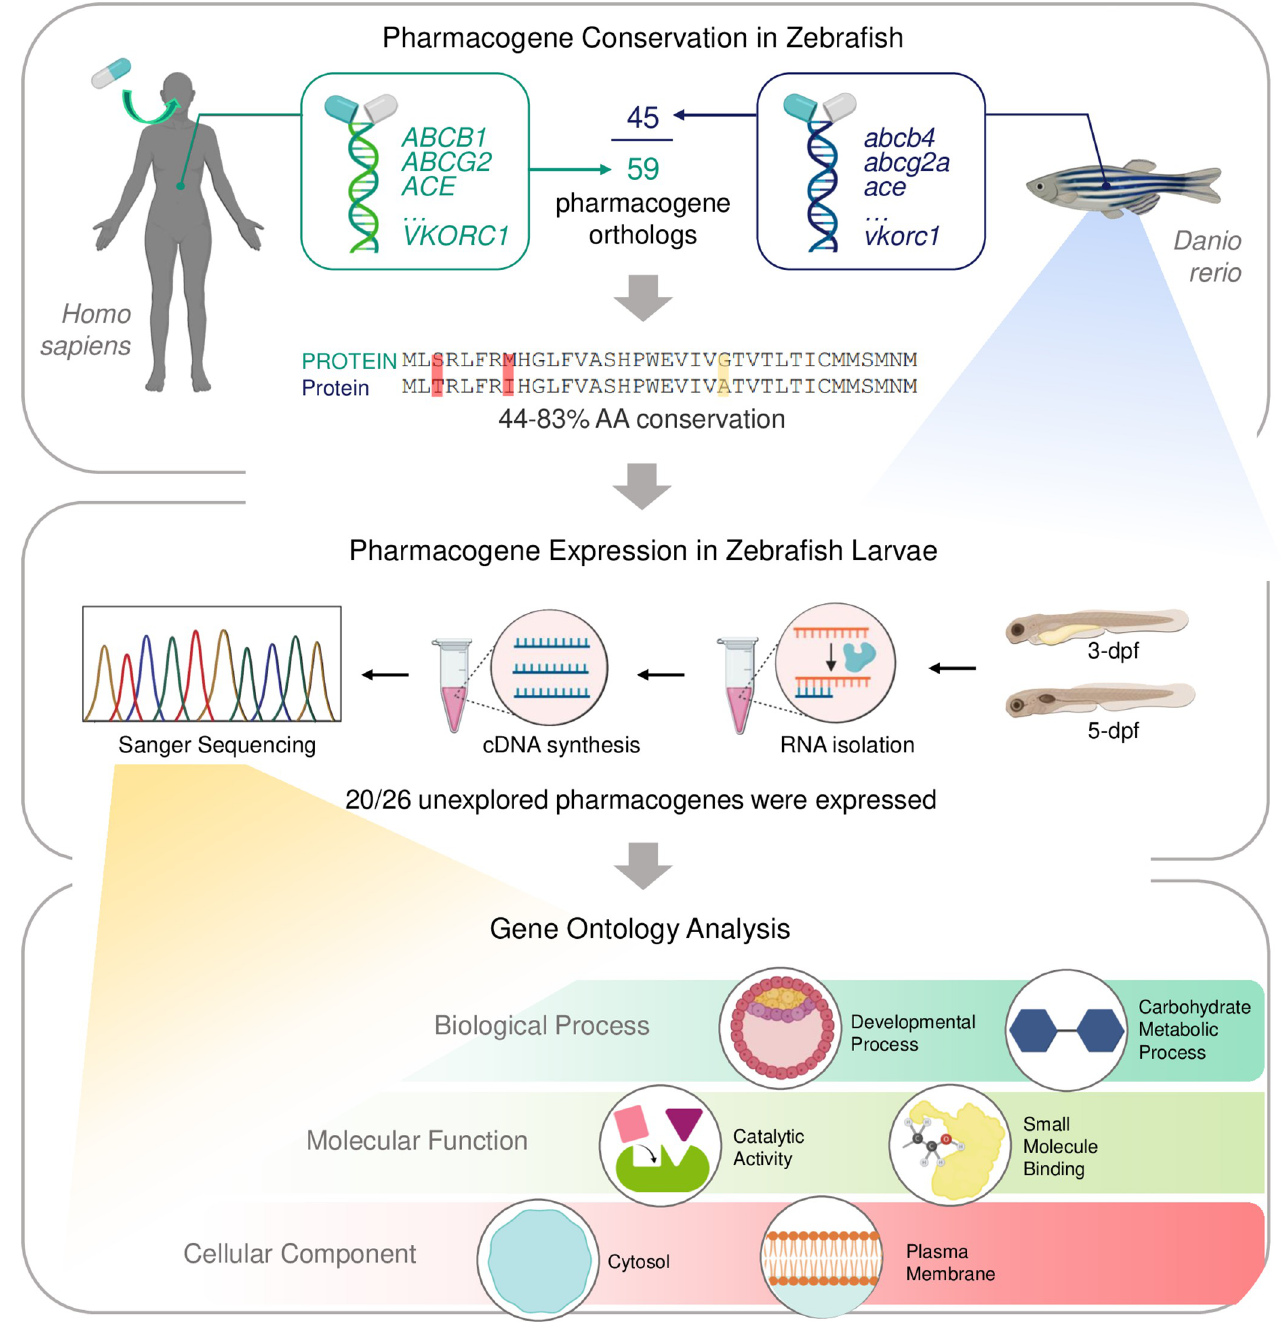
Fig 8. Summary of study design and novel findings. Out of 59 Tier 1 and 2 human pharmacogenes, 45 were determined to have a zebrafish ortholog. The range of amino acid conservation between species was 44 – 83%. For pharmacogenes without published expression data, 3- and 5-dpf zebrafish were collected for gene expression analysis. Expression was demonstrated for 20 out of 26 previously unexplored pharmacogene orthologs. Gene ontology analysis of all 45 pharmacogene orthologs identified the top Biological Process, Molecular Function, and Cellular Component terms for future research, based on the number of highly conserved genes associated with each